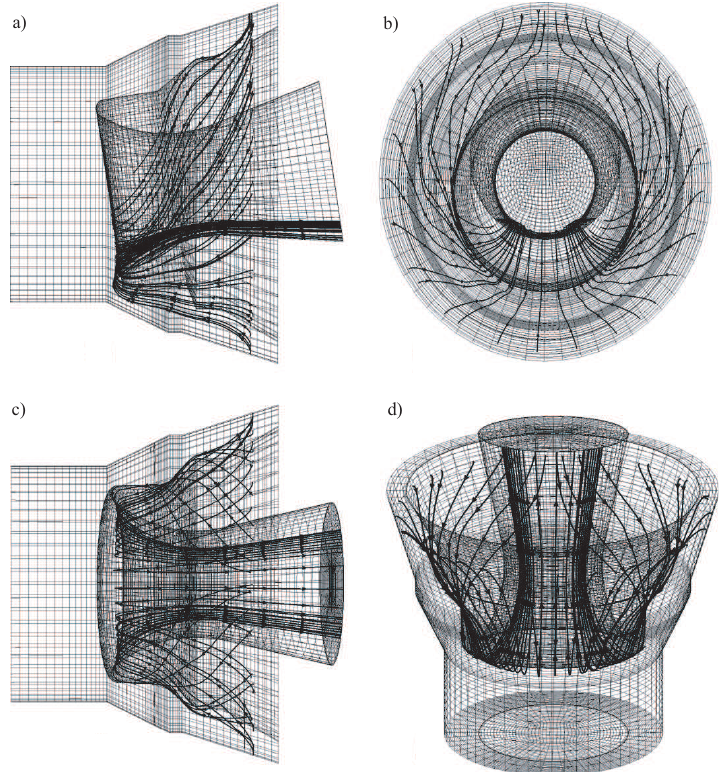
Figure 20. Streamlines near the rear nozzle head for cylindrical channel ( α = 9 ◦ ): view in xy plane ( a ), view in yz plane ( b ), view in xz plane ( c ), three-dimensional view ( d ).